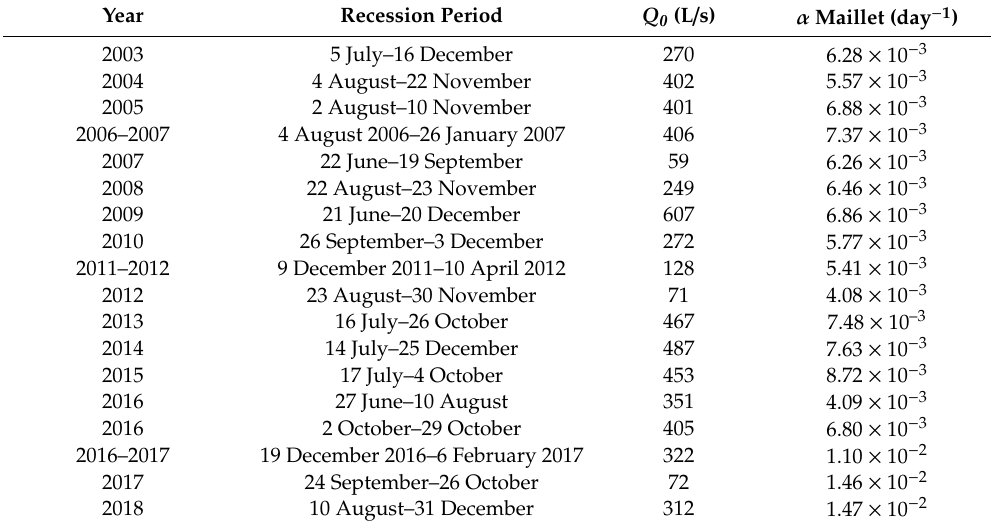
Table 4. Maillet depletion coe ffi cients α and values of Q 0 for the analyzed recession periods. Data under the red line are related to post 30 October 2016 recession periods.